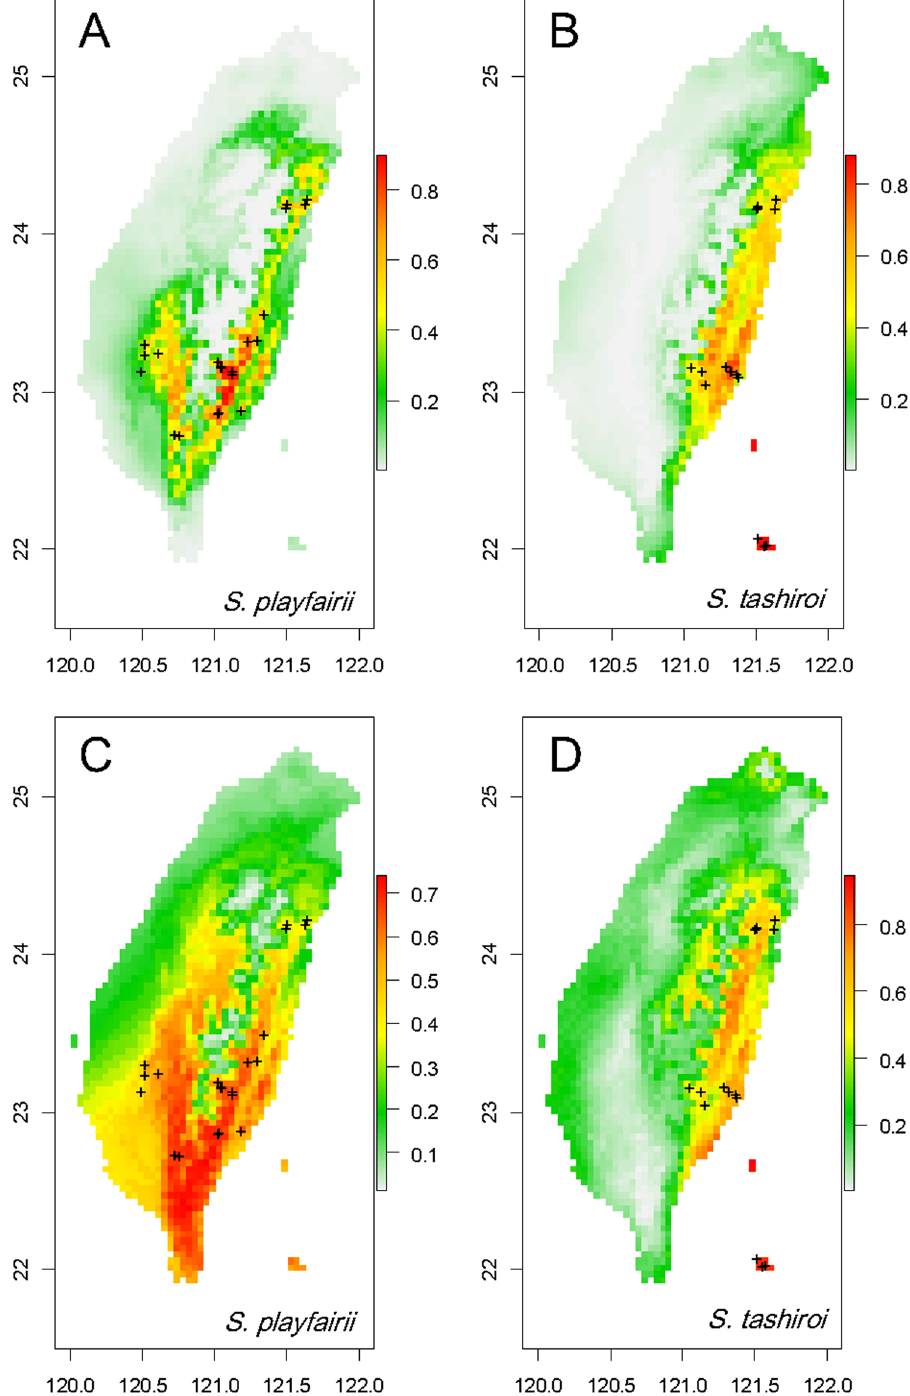
Figure 5. Ecological niche modeling for predicting the potential distributions of S . playfairii and S . tashiroi . ( A , B ) are the potential distributions inferred by all 71 collected environmental variables; ( C , D ) were predicted by the remaining five variables after removing variables of multicollinearity. The map was constructed using the packages maptools 69 implemented in